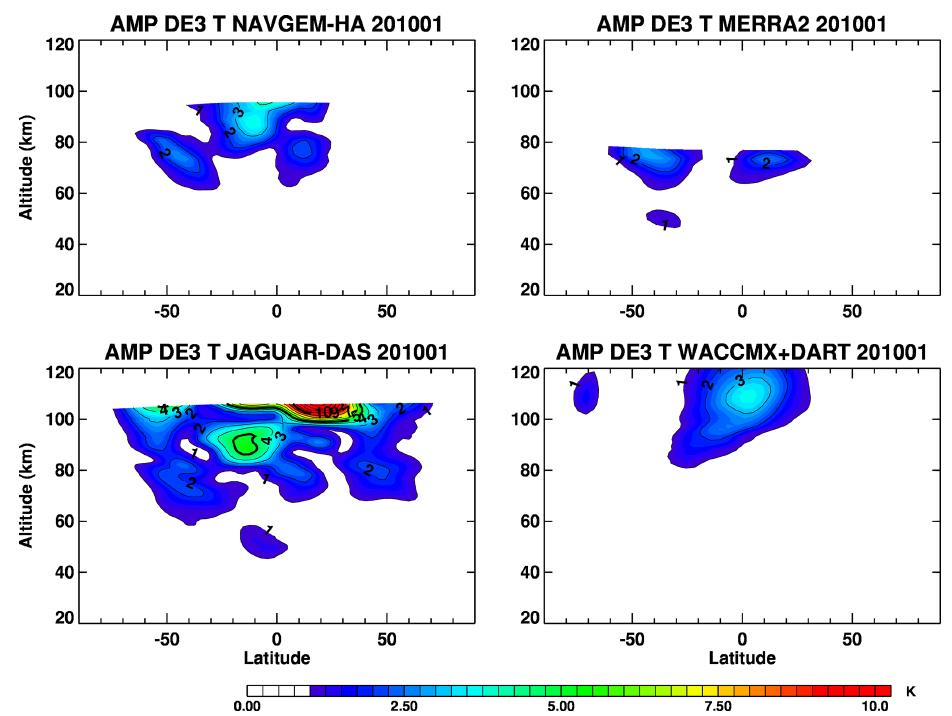
Figure 17. Monthly mean amplitude of the nonmigrating wave 3 diurnal tide (DE3) in temperature for January 2010 from NAVGEM-HA, MERRA2, JAGUAR-DAS, and WACCMX +